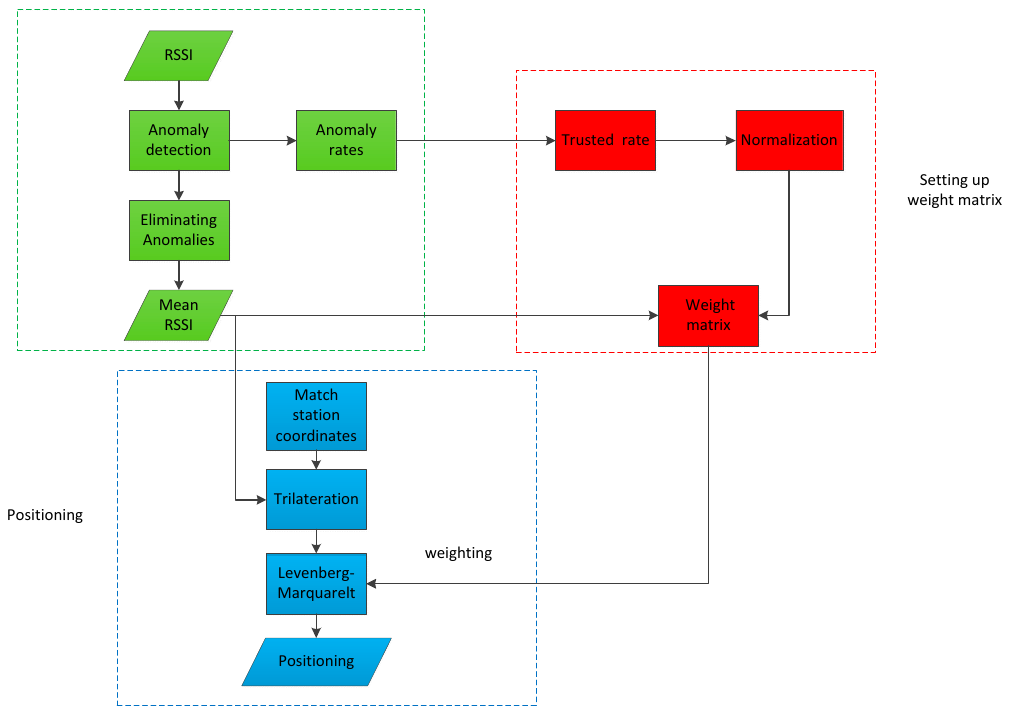
Figure 1. The workflow of anomaly detection and positioning.